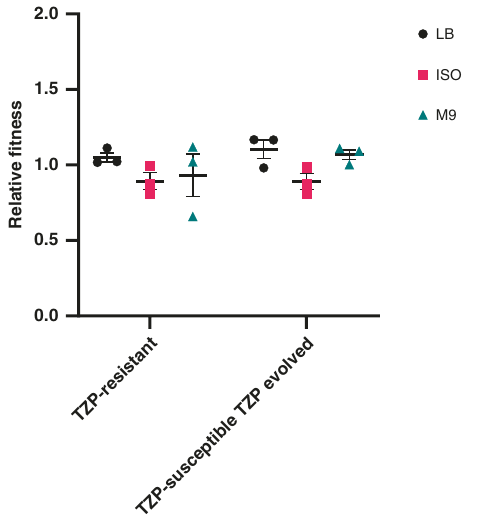
Fig. 4 Gene ampli fi cation did not incur a fi tness cost in the piperacillin/ tazobactam-resistant isolate compared to the piperacillin/tazobactam- susceptible isolate. Relative fi tness of the piperacillin/tazobactam (TZP)- resistant isolate compared to the TZP-susceptible isolate and the TZP- susceptible isolate grown in the presence of TZP compared to the TZP- susceptible isolate grown in the absence of TZP, assessed comparatively in LB broth (LB, black circles), iso-sensitest broth (ISO, pink squares) and M9 (green triangles). All error bars represent the standard error of the mean ( n = 3). Source data are provided as a Source Data fi